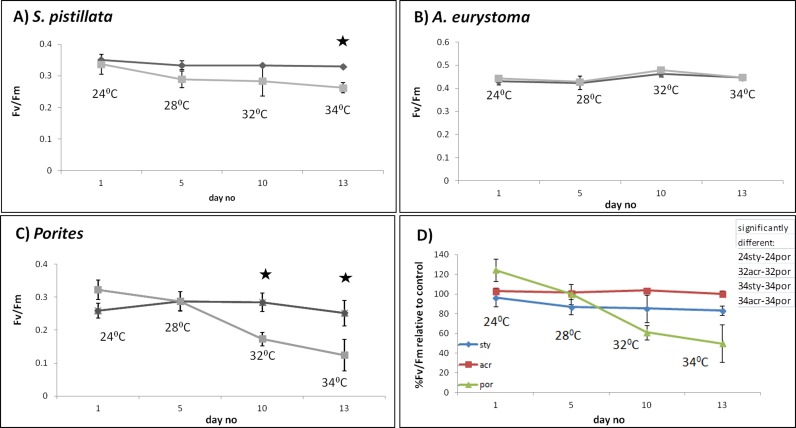
Maximum quantum yield of coral fragment symbionts throughout the experiment.Maximum quantum yield (Fv∕Fm) values for heat-stressed (light grey) and control (dark grey) coral fragments; (A) S. pistillata, (B) A. eurystoma and (C) Porites. Asterisk represents a significant difference between control and treatment (p < 0.05). (D) Percentage of Fv∕Fm relative to control for the three studied coral species, as indicated in the legend. The table in the upper right hand corner represents the significantly different treatments (using post hoc LSD multiple-comparisons) (por; Porites sp., sty; S. pistillata, acr; A. eurystoma 24, 28, 32 and 34; fragments sampled at the time points corresponding to 28 °C, 32 °C, 34 °C).